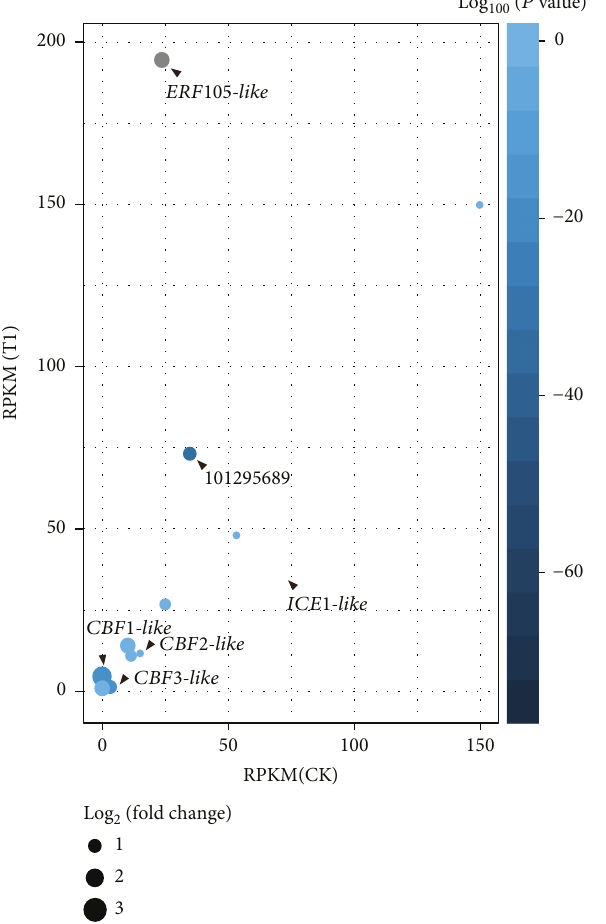
Figure 8: Transcriptional response of cold stress-involved components. Gene RPKM values of CK and T1 were plotted within the x -axis and y -axis, respectively. CBF-like genes and potential regulators in F. vesca were indicated by arrows.